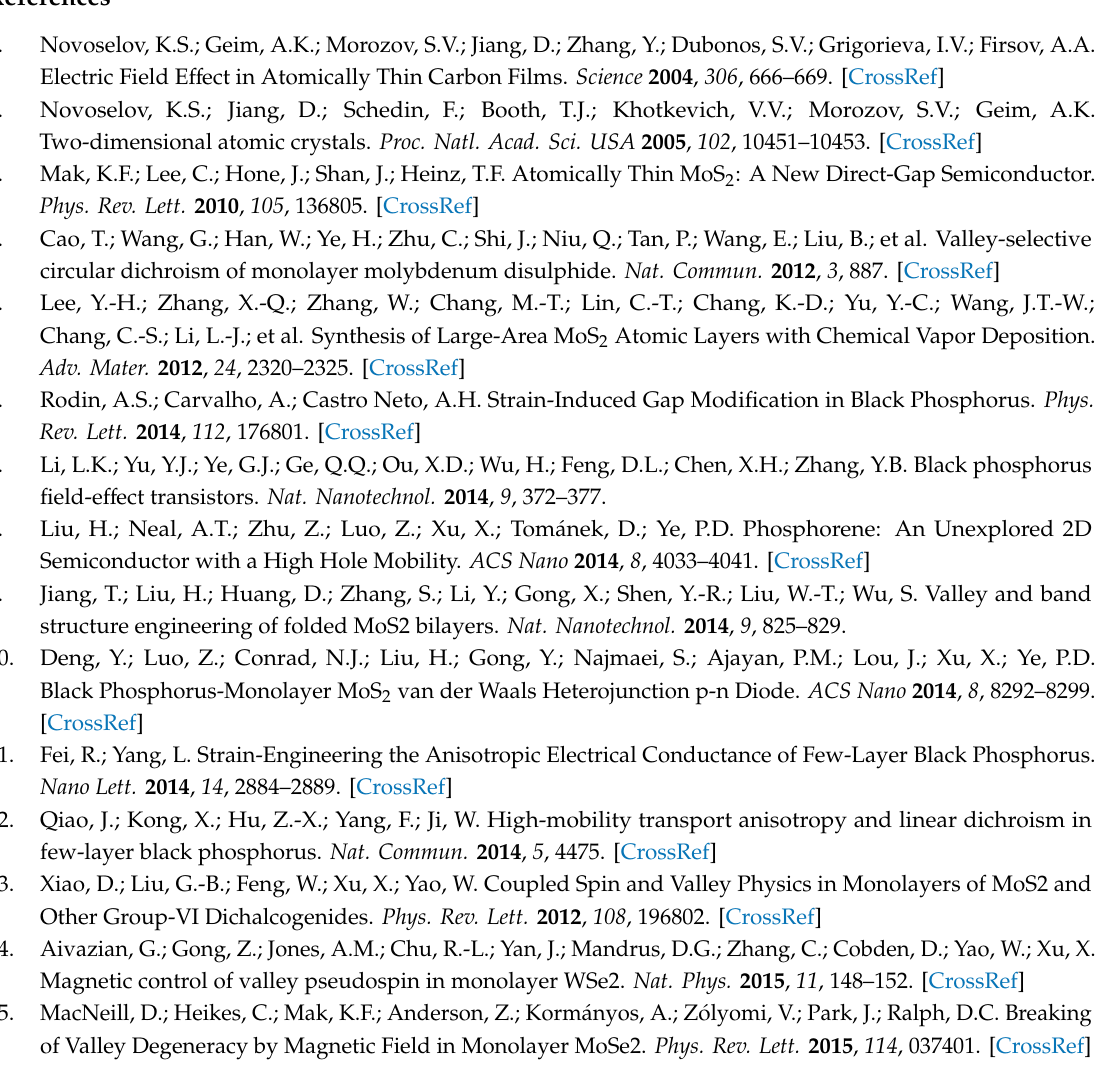
Figure S1: The band structures of InSe / FeI 2 heterostructures with C-2 to C-6 configurations (a–e). The red solid dots indicate the contributions from InSe with their size reflecting the relative weight. Figure S2: Spin density for C-1 (a) and C-3 (b) configurations. The red and blue color represent charge accumulation and depletion, respectively. The isosurface value of 0.0003 e · Å − 3 . The green, pink purple and brown balls represent Se, In, I and Fe atoms,